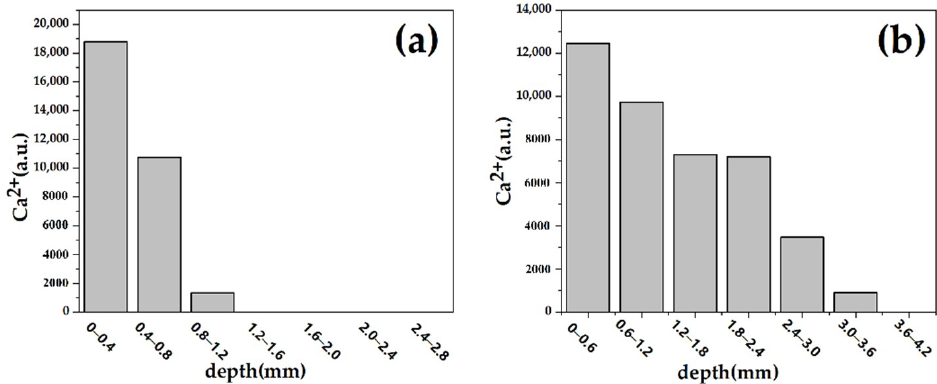
Figure 10. P enetration distribution of different crystal types of calcium carbonate in sandstone . ( a